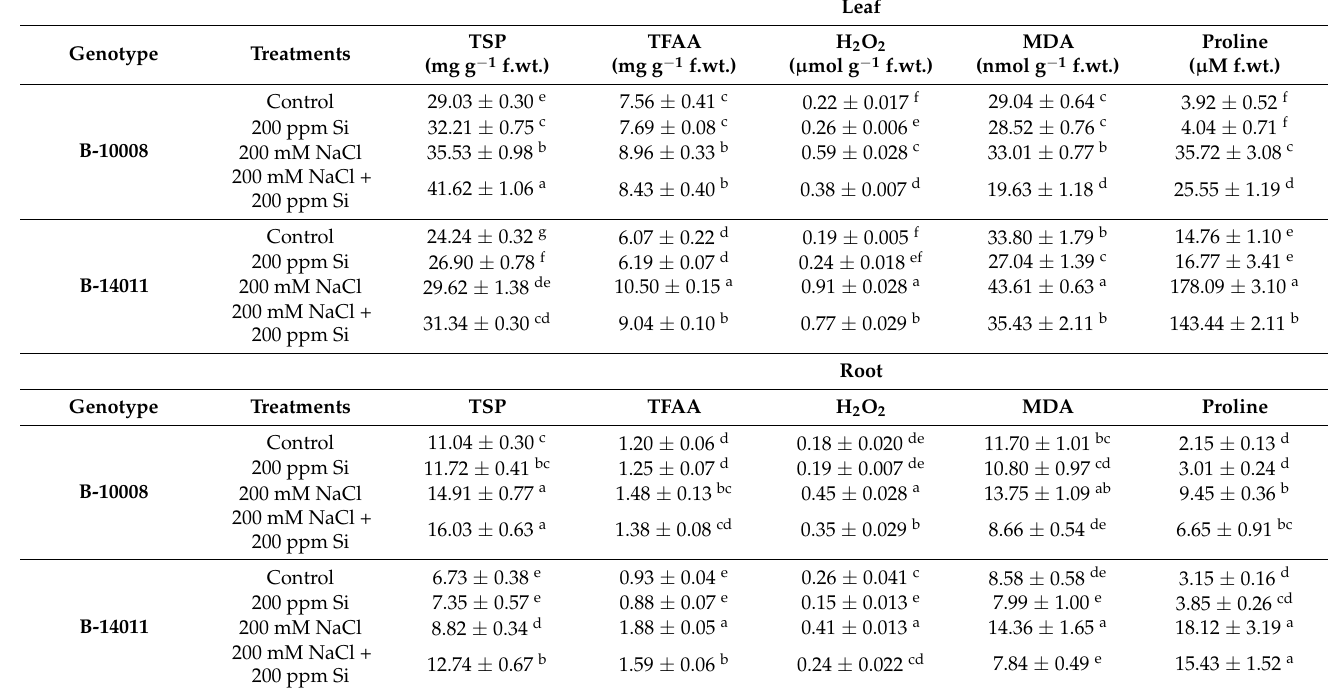
Table 2. Total soluble protein (TSP), total free amino acid (TFAA), hydrogen peroxide (H 2 O 2 ), malondialdehyde (MDA) and proline ( µ M f.wt.) contents in leaf and root of barley genotypes modulated by rooting application of silicon under salinity